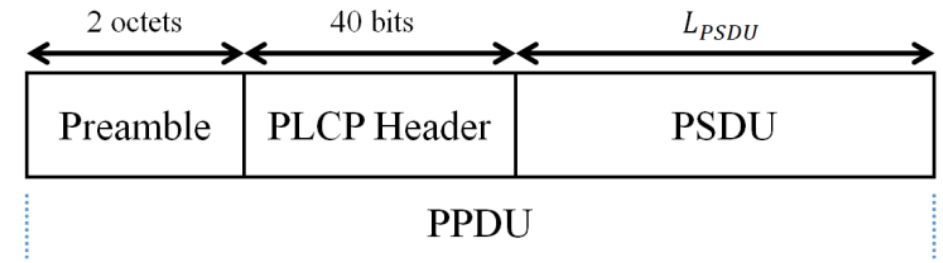
Figure 1. Packet format at the physical layer (PHY). Table 1. PHY